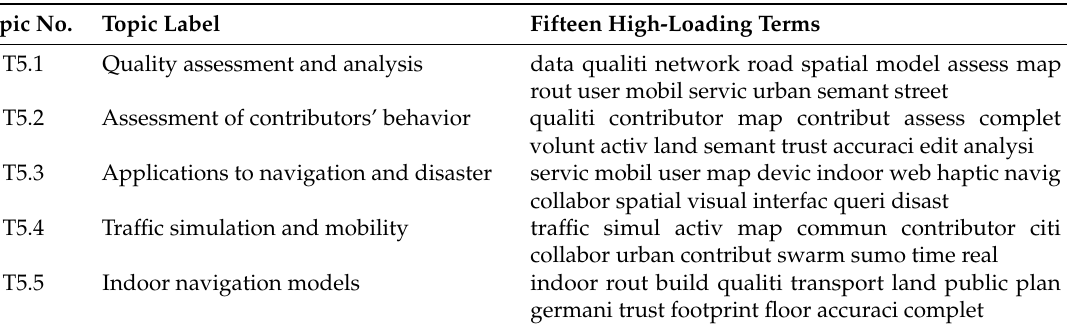
Table 5. Five topic-based term loading